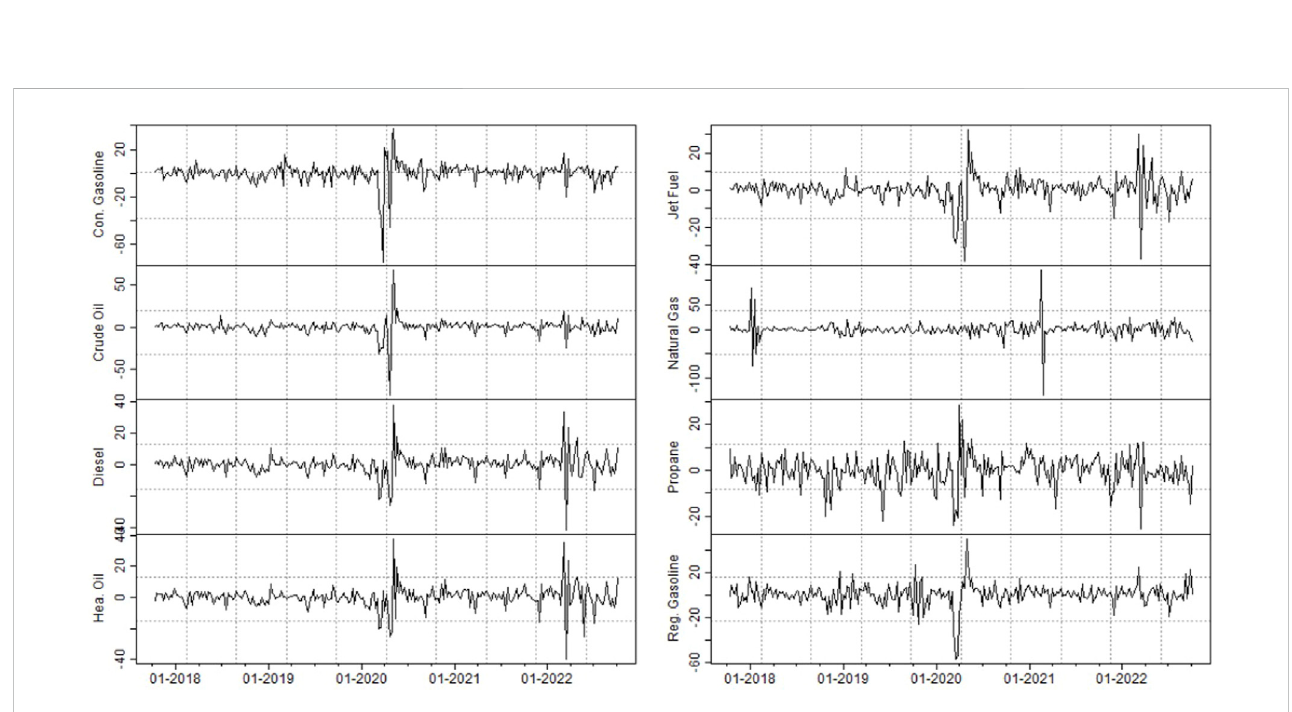
FIGURE 2 Change rates of energycommodities (%). The lable are the same as noted in Table